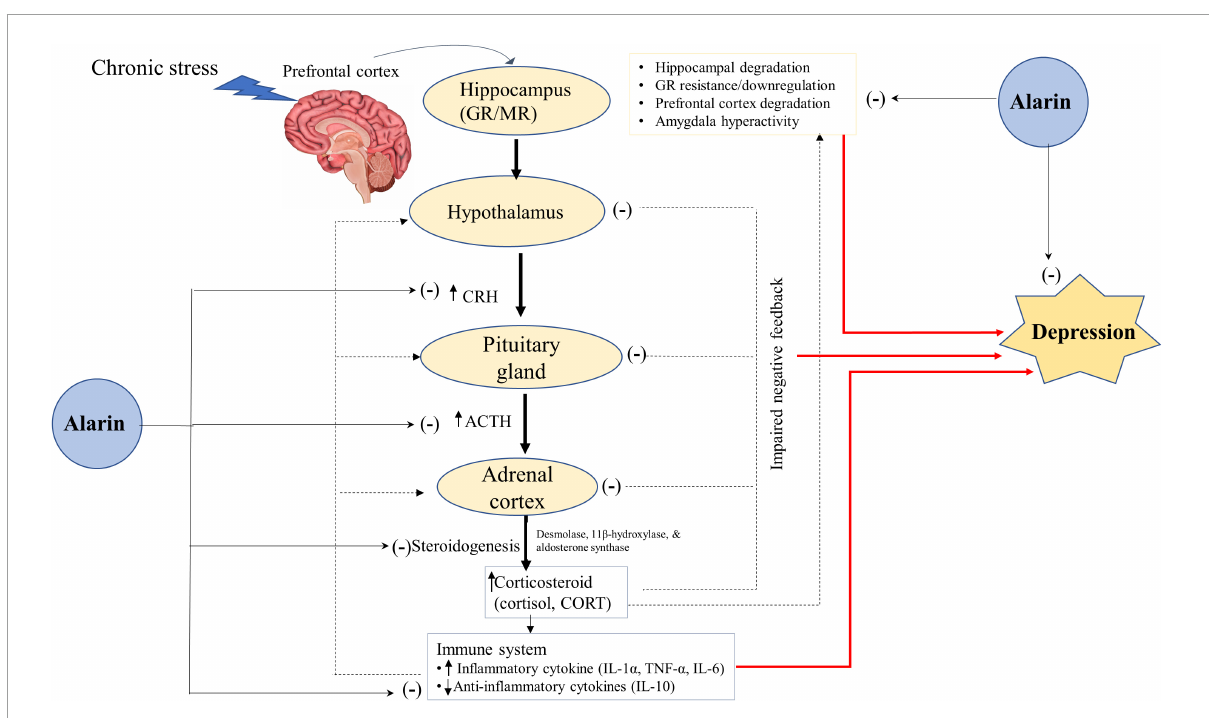
FIGURE2 A hypothetical antidepressant activity of alarin through the regulation of the HPA-axis. Alarin relieves depression by acting as a hormone regulator that downregulates the activity of the HPA axis (CRH, ACTH, and Corticosteroids), and an enzyme inhibitor that decreases the expression of enzymes involved in steroidogenesis (desmolase, 11 β -hydroxylase, and aldosterone synthase), thus lowering corticosteroid hormone synthesis. Besides, alarin alleviates depression by reducing HPA-axis overactivity resulting from increased pro-inflammatory cytokines (IL-1 α , TNF- α , and IL-6) and decreased anti-inflammatory cytokines (IL-10). Alarin also has antidepressant properties due to its ability to restore hippocampal volume loss, GR resistance/downregulation, prefrontal cortex degradation, and amygdala hyperactivity. Arrow ends ( → ) indicate a stimulatory effect, while negative signs (–) show an inhibitory effect. ACTH, adrenocorticotropic hormone; CORT, corticosterone; CRH, corticotropin-releasing hormone; GR, glucocorticoid receptor; HPA, hypothalamic-pituitary-adrenal; IL, interleukin; MR, mineralocorticoid receptor; TNF, tumor necrosis